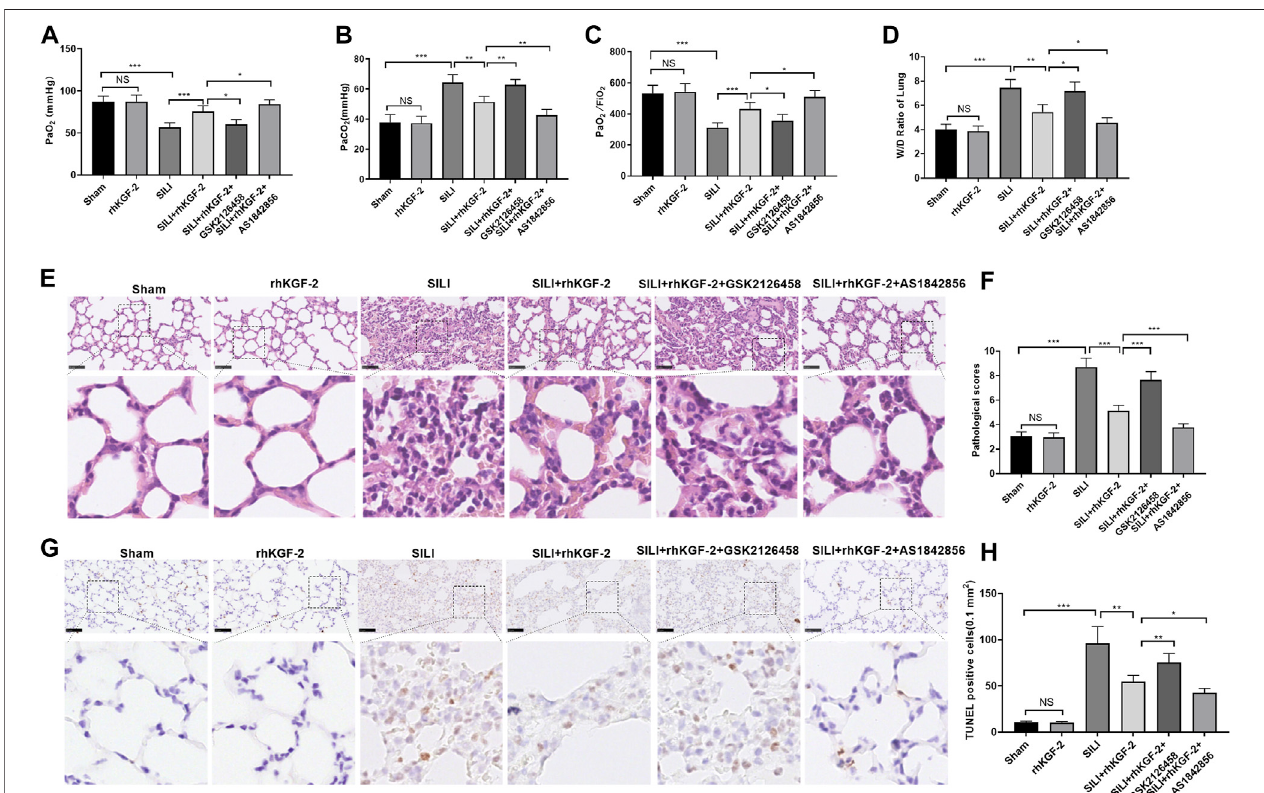
FIGURE 5 | The role of rhKGF-2 SILI rat model. The SILI rat model was established by inhalation of smoke. Then, rhKGF-2 (10 ng/kg body weight), GSK2126458 (300 μ g/kgbodyweight)andAS1842856(10 μ g/kgbodyweight)wereusedfortreatingtheSILIrats,thesame volumeofsalinewasadministered ontheratinthesham group. (A – C) . The arterial blood of rats was extracted to detect the values of PaO 2 , PaCO 2 , PaO 2 /FiO 2 to analyze the pulmonary function. The Y -axis of panel A and B represents the partial pressure of O 2 and CO 2 (mmHg). The Y -axis of panel C represents the Oxygenation index (the ratio of arterial partial pressure of oxygen to inhaled oxygen concentration) (mmHg). (D) . The wet weight (W) and dry weight of the rat lung were measured, and the W/D ratio was calculated to evaluate the pulmonary edema. (E) . HE staining was performed to observe the pathological changes of rat lung in each group. (F) . The pathological scores of rat lung in each group were counted. (G) . TUNEL assay was implemented to analyze apoptosis in the lung tissues. (H) . The number of TUNEL-positive cells in an area of 0.1 mm 2 was calculated. Scale bar (cid:2) 50 μ m. Data are expressed as mean ± SD. All experiments were repeated for three times. Data difference was analyzed via ANOVA,